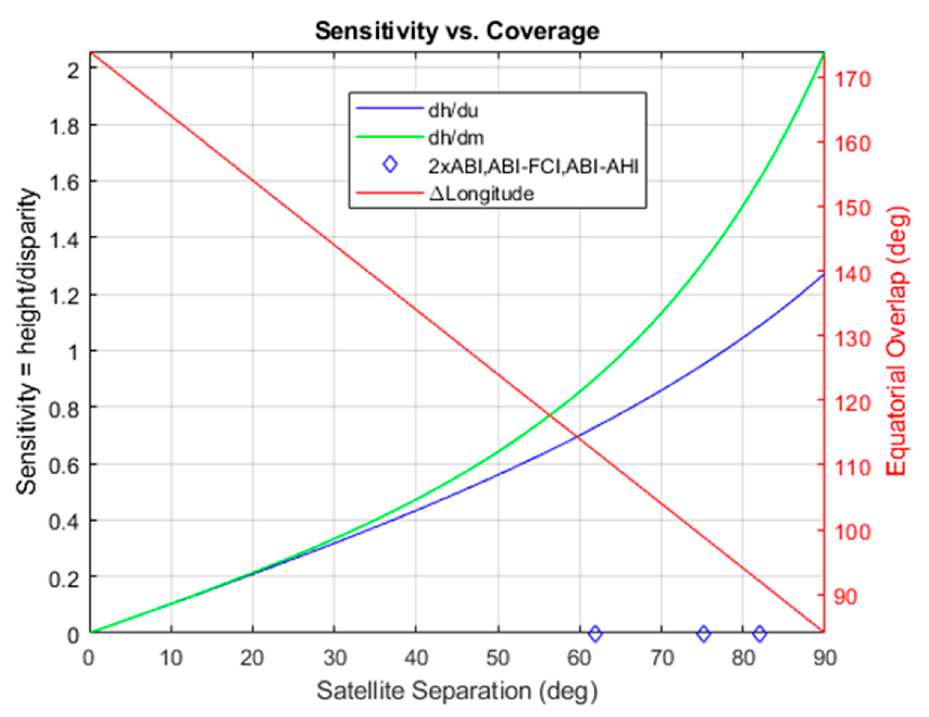
Figure 29. Sensitivity versus coverage is shown as a function of the difference in longitude between the satellites. The coverage is measured between the horizons of the respective satellites along the equator (but may exceed practical limits on the usable imagery). Sensitivities are calculated for the midpoint of the coverage area along the equator.